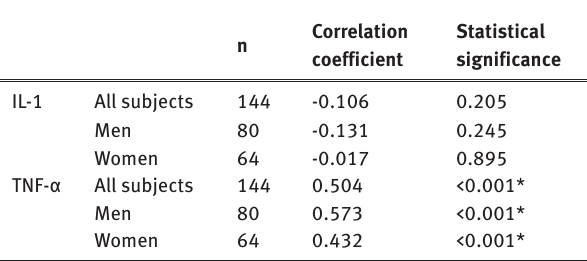
Table 2: The age-related trends of plasma cytokines levels in our